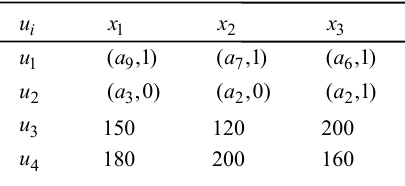
Table 3. Preference information given by decision maker